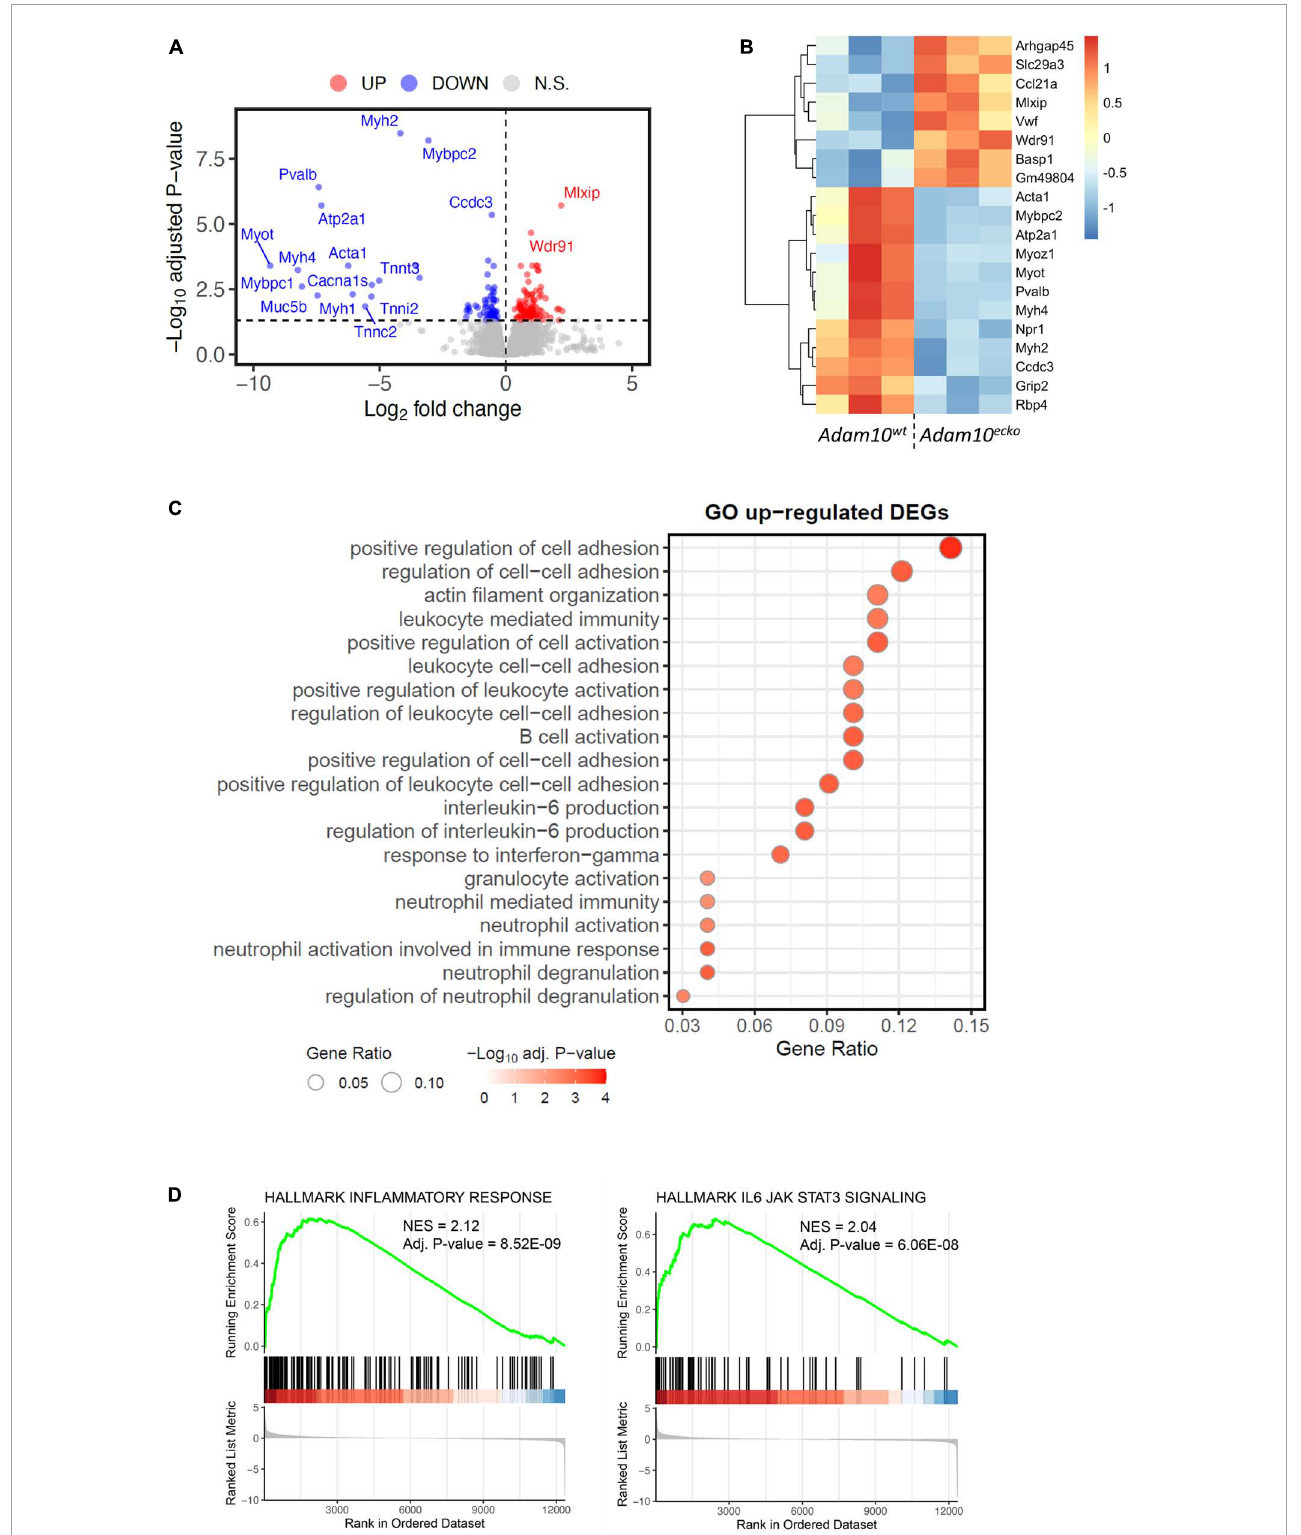
FIGURE4 RNA-sequencing demonstrates an inflammatory genetic profile in vessels from Adam10 ecko mice. (A) Volcano plot visualizing up-/downregulated genes in Adam10 ecko vs. Adam10 wt mice. Horizontal line represents adjusted p -value of 0.05, while vertical lines represent log2FC of 0. N.S., not-significant. (B) Heatmap of top 20 most differentially expressed genes. Variance stabilizing transformed expression values are z-normalized per gene/row. (C) Gene ontology of vessels from Adam10 ecko vs. Adam10 wt mice evaluated by GSOA. (D) GSEA figures showing the dysregulation of inflammatory responses and IL6-JAK-STAT3 signaling in Adam10 ecko vs. Adam10 wt